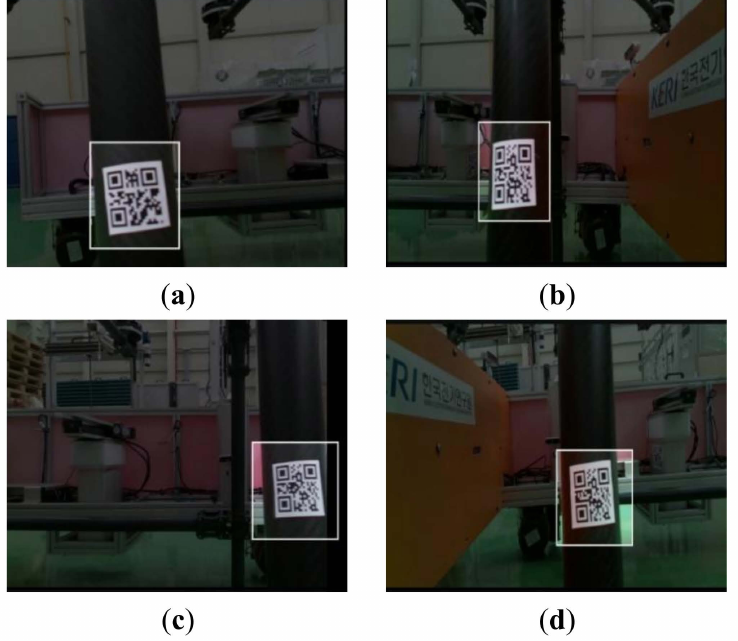
Figure 15. Precision-control marker where a translation error occurs. ( a ) Image shot from the left front camera (angular error: 0.02 ◦ , distance of 2 cm); ( b ) image shot from the left rear camera (angular error: 0.01 ◦ , distance: 1.94 cm); ( c ) image shot from the right front camera (angular error: 0.02 ◦ , distance: 5 cm); ( d ) image shot from the left front camera (angular error: 0.03 ◦ , distance error: 5.06